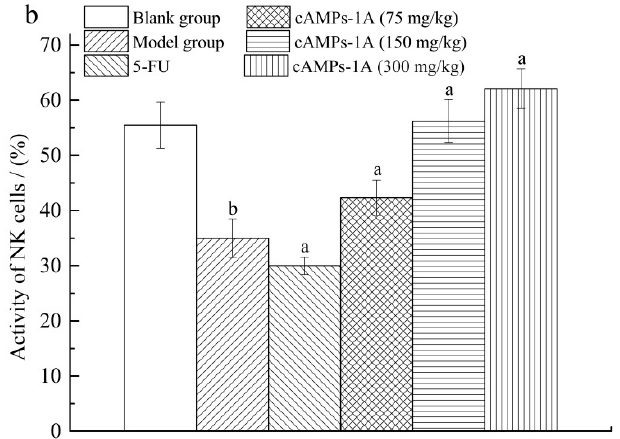
Figure 4. Effects of cAMPs-1A on macrophages pinocytosis ( a ) and NK cells activity ( b ) in H22-bearing mice. Note: a p < 0.05 compared to model group; b p < 0.05 compared to blank group.